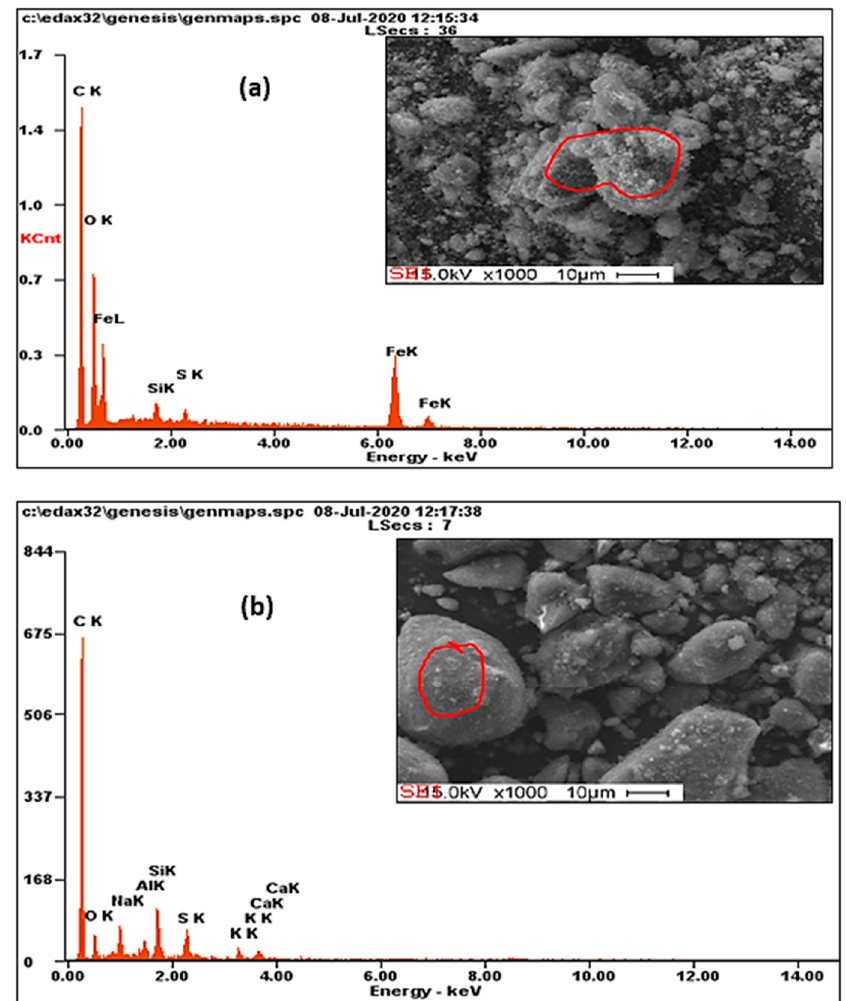
Figure 4. EDX profiles of tire waste-derived M-AC ( a ) and AC ( b ). Table 1. Elemental composition of tire waste-derived AC and M-AC. Element